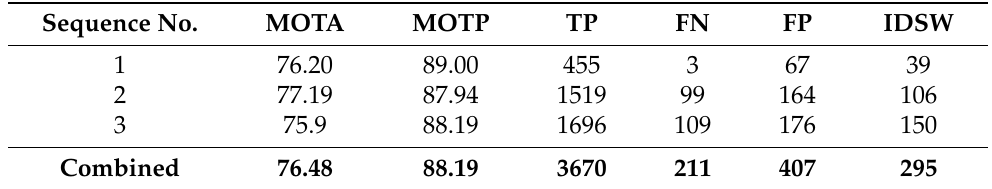
Table 7. Scenario 3—category 2 Quantitative results of the tracker’s performance to track objects of category 2 (tugboat) in scenario 3. Scenario 3 consists of three sequences involving both moving and static objects, occlusions of the camera’s viewpoint are